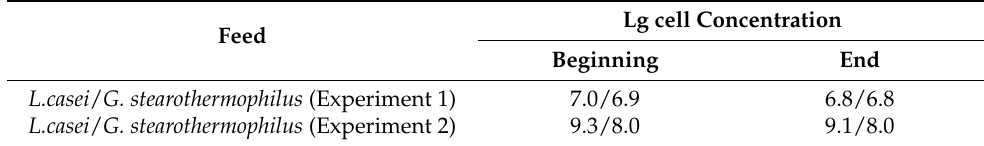
Table A3. Bacterial concentration of feed at the beginning and end of the experiments (cfu/g).